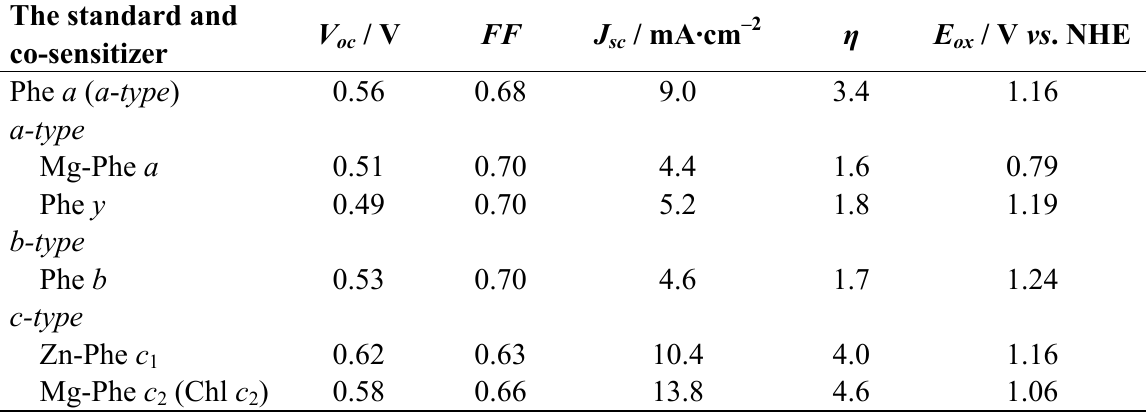
), fill factor ( FF ), short-circuit photo-current Table 4. The open-circuit photovoltage ( V oc density ( J ), conversion efficiency ( η ) of the singly-sensitized solar cells and the sc one-electron oxidation potential ( E ) of each ox